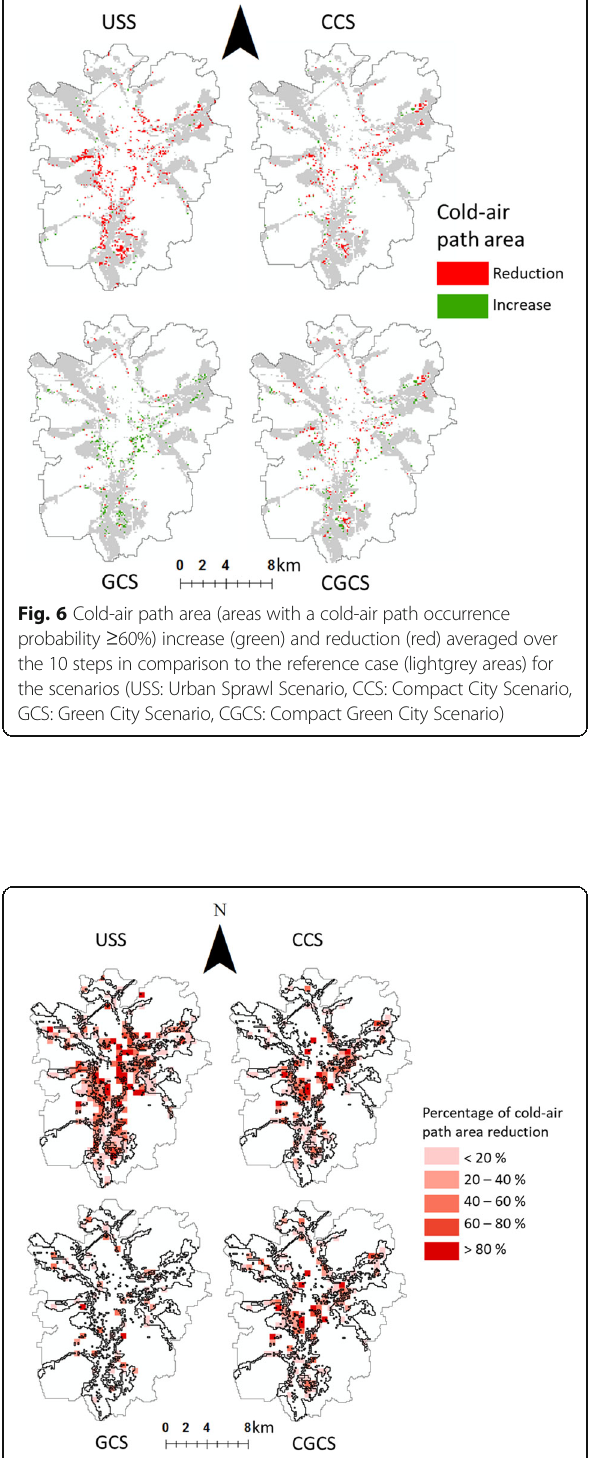
Fig. 7 The percentage of cold-air path area reduction in comparison to the cold-air path area of REF for all scenarios is shown for 500 × 500 m resolution (red scales). For comparison, the outlines of the cold-air paths of REF are shown in